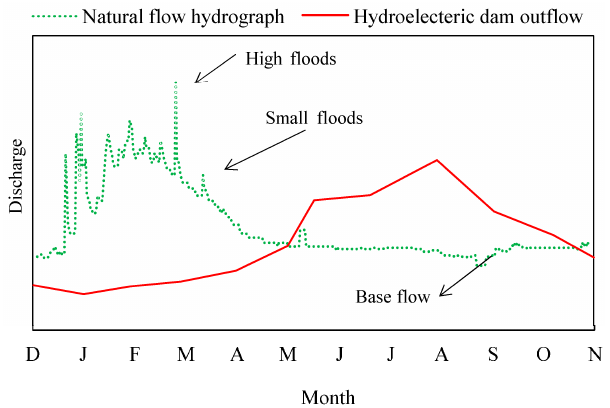
Figure 1. Schematic of hydrological regime of a natural and an anthropogenic river with a hydro ‐ power dam. dropower